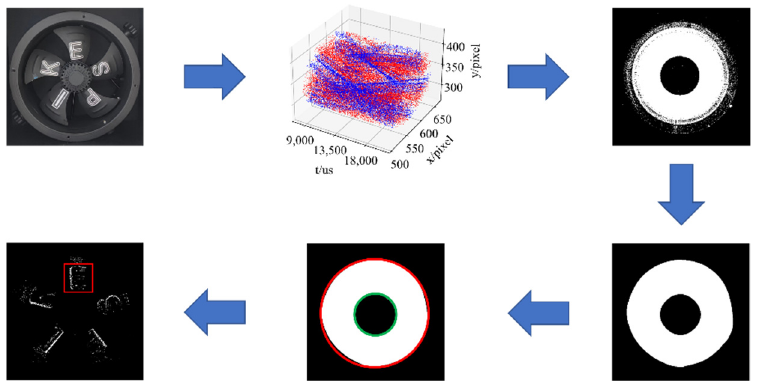
Figure 6. Illustration of setting a ROI. First, the events over a long period of time are aggregated, and due to the rotation of the fan, a ring will be formed. The image is then filtered and clustered to remove noise, and two concentric circles are fitted. Finally, a square ROI is anchored just above the center of the circle with the radius difference between the two circles as the side length.